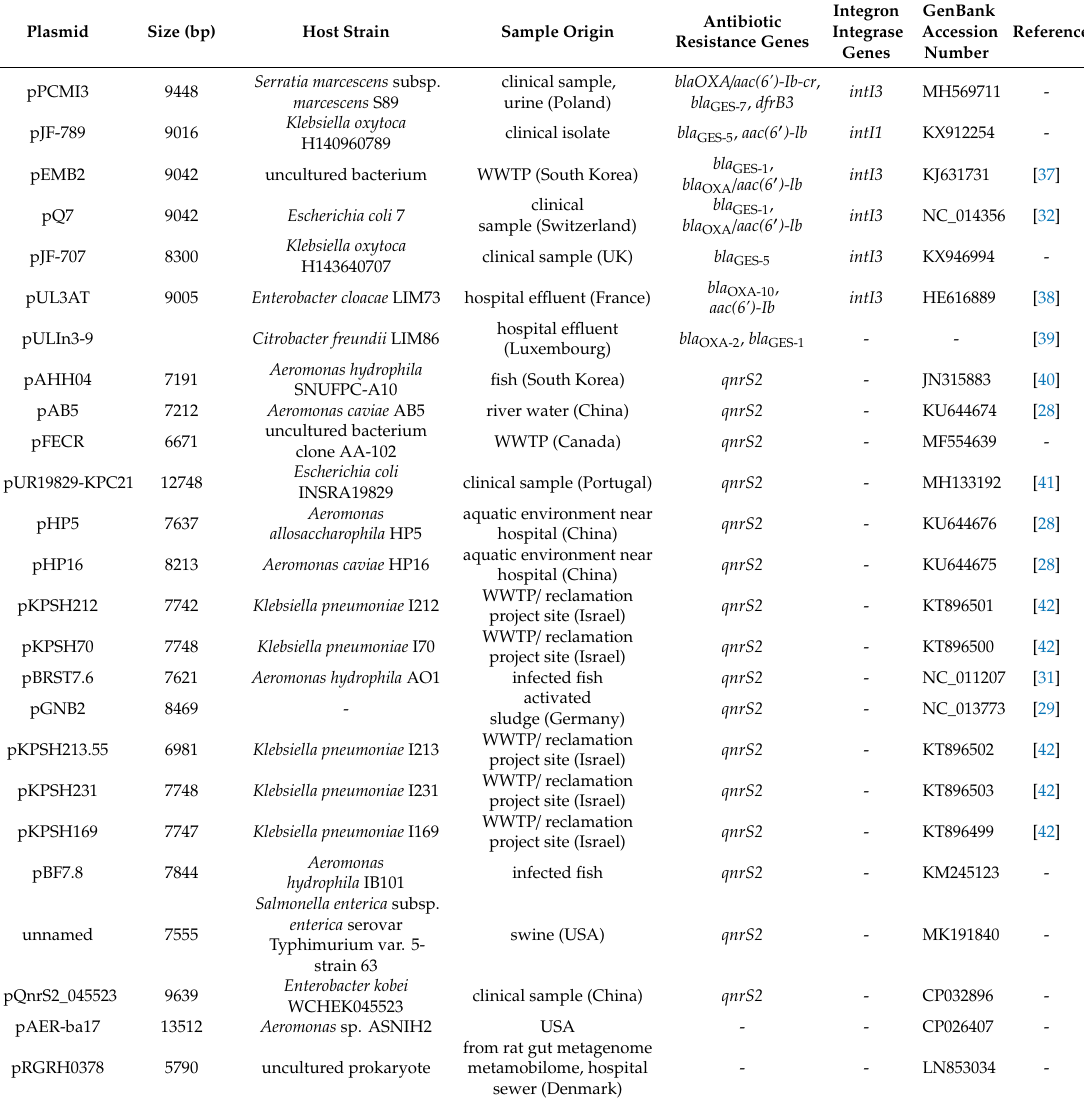
Table 2. Summarized information concerning IncQ-3 plasmids retrieved from the GenBank (NCBI)